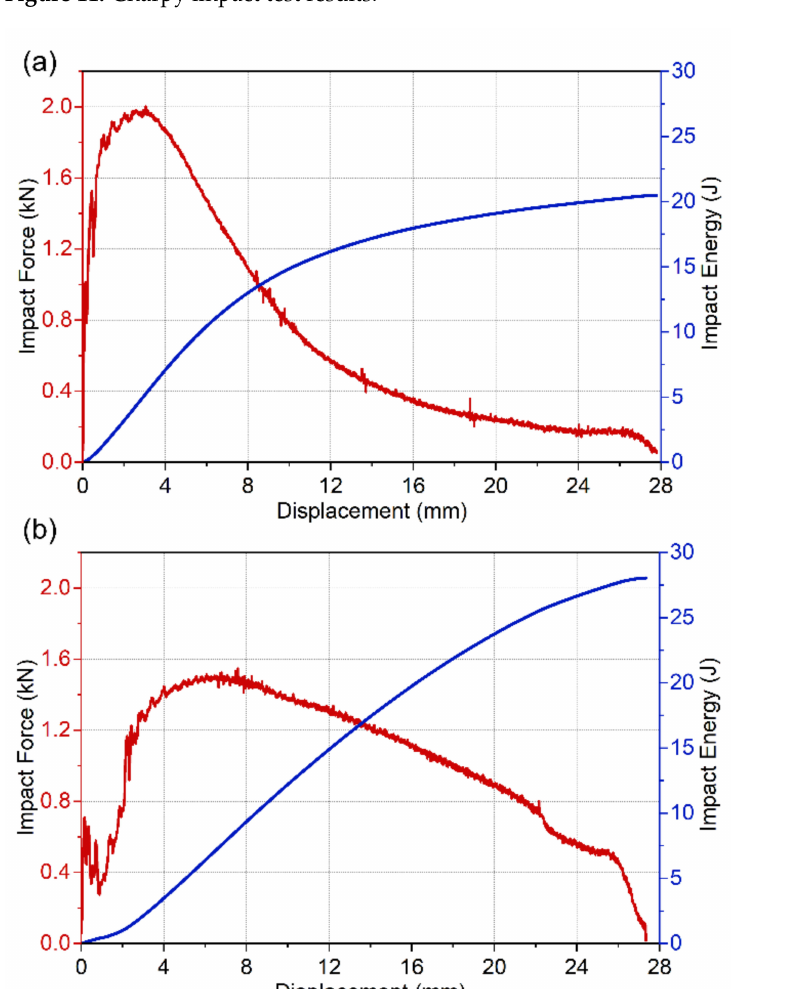
Figure 12. Force-time charts for ( a ) base metal; ( b ) specimen A4-1.